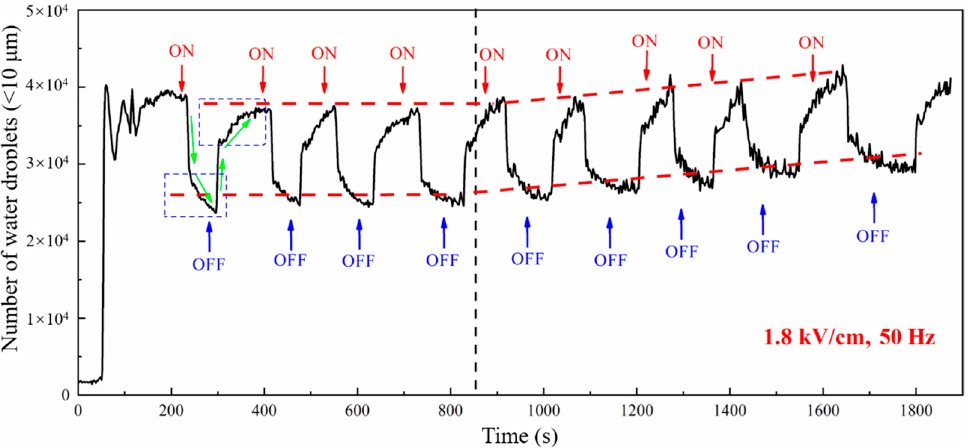
Figure 5. Variations of water droplets number within 10 µ m.